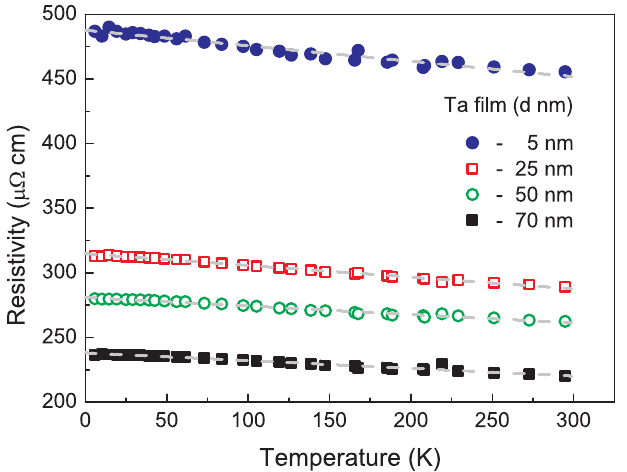
Figure 2. Temperature dependence of dc resistivity of the β -Ta films with thickness of 5.0, 25, 50, and 70 nm. Dashed lines represent the result of approximation by the linear dependence in the studied temperature